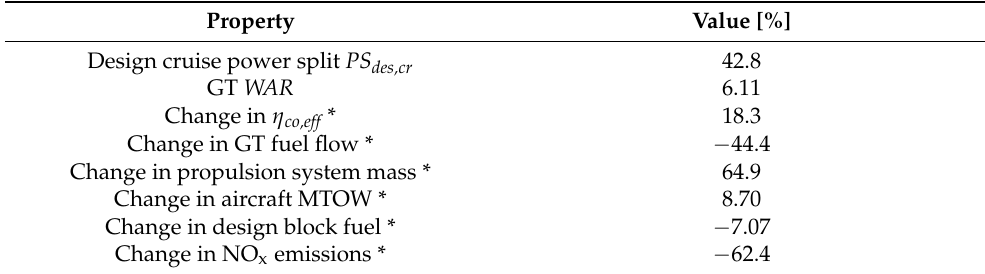
Table 7. Summary of key characteristics of block fuel optimum aircraft design based on selected SOFC technology